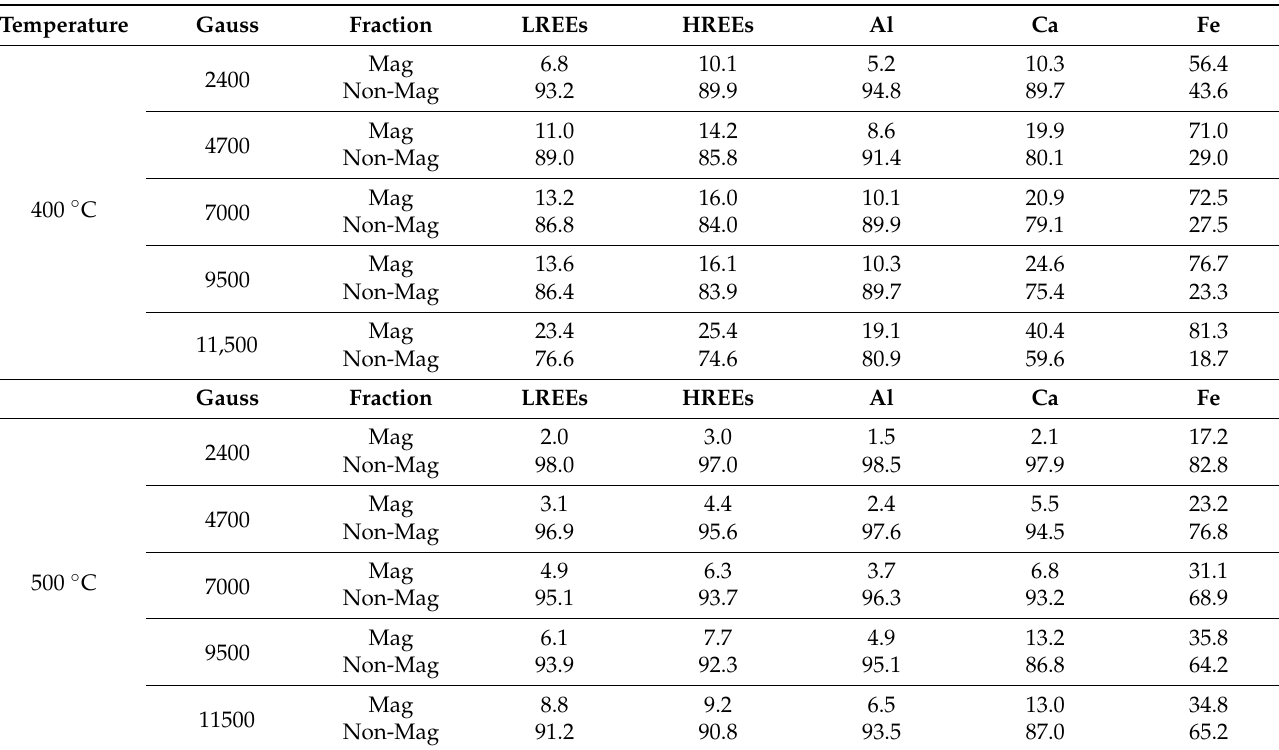
Table 3. Mass distribution % in magnetic and non-magnetic products obtained at different magnetic strengths for 400 ◦ C and 500 ◦ C calcined